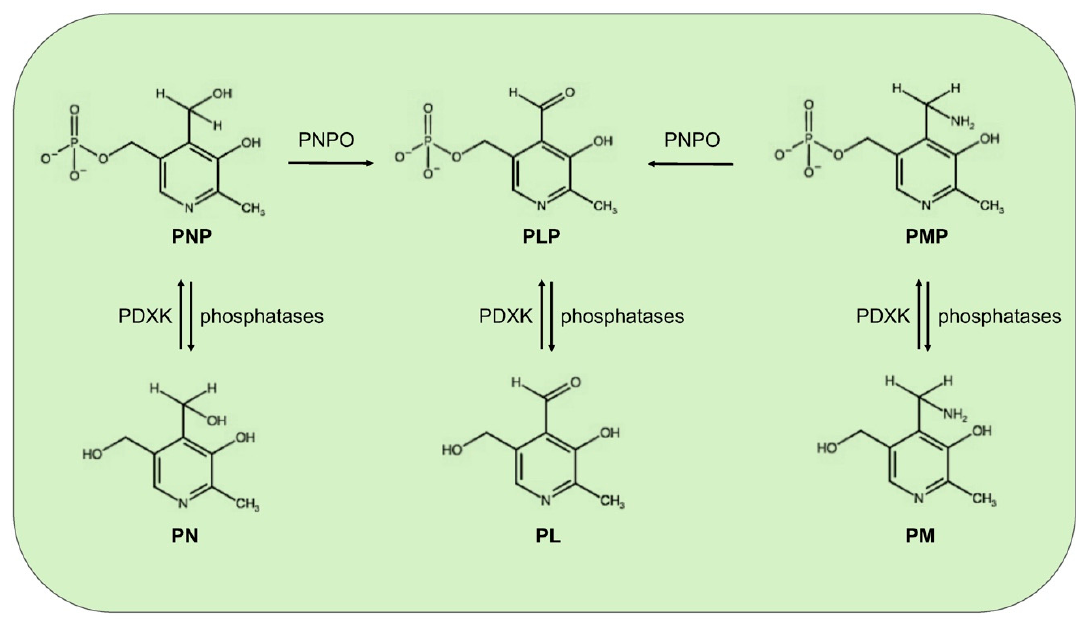
Figure 1. Schematic vitamin B6 metabolism in humans. The diagram corresponds to the pyridoxal 5 ′ -phosphate salvage pathway. PLP, pyridoxal 5 ′ -phosphate; PNP, pyridoxine 5 ′ -phosphate; PMP, pyridoxamine 5 ′ -phosphate; PL, pyridoxal; PN, pyridoxine; PM, pyridoxamine; PDXK, pyridoxal kinase; and PNPO, pyridoxine 5 ′ -phosphate oxidase.